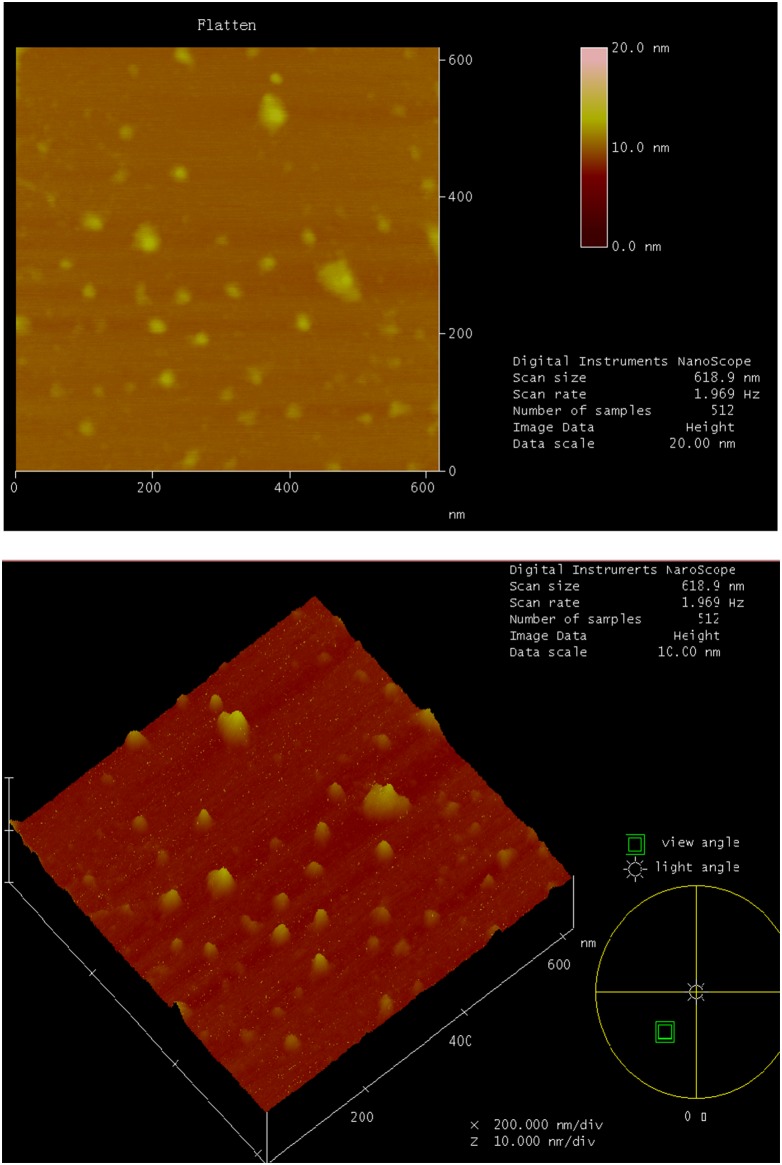
AFM micrographs of TAT-MPLs.